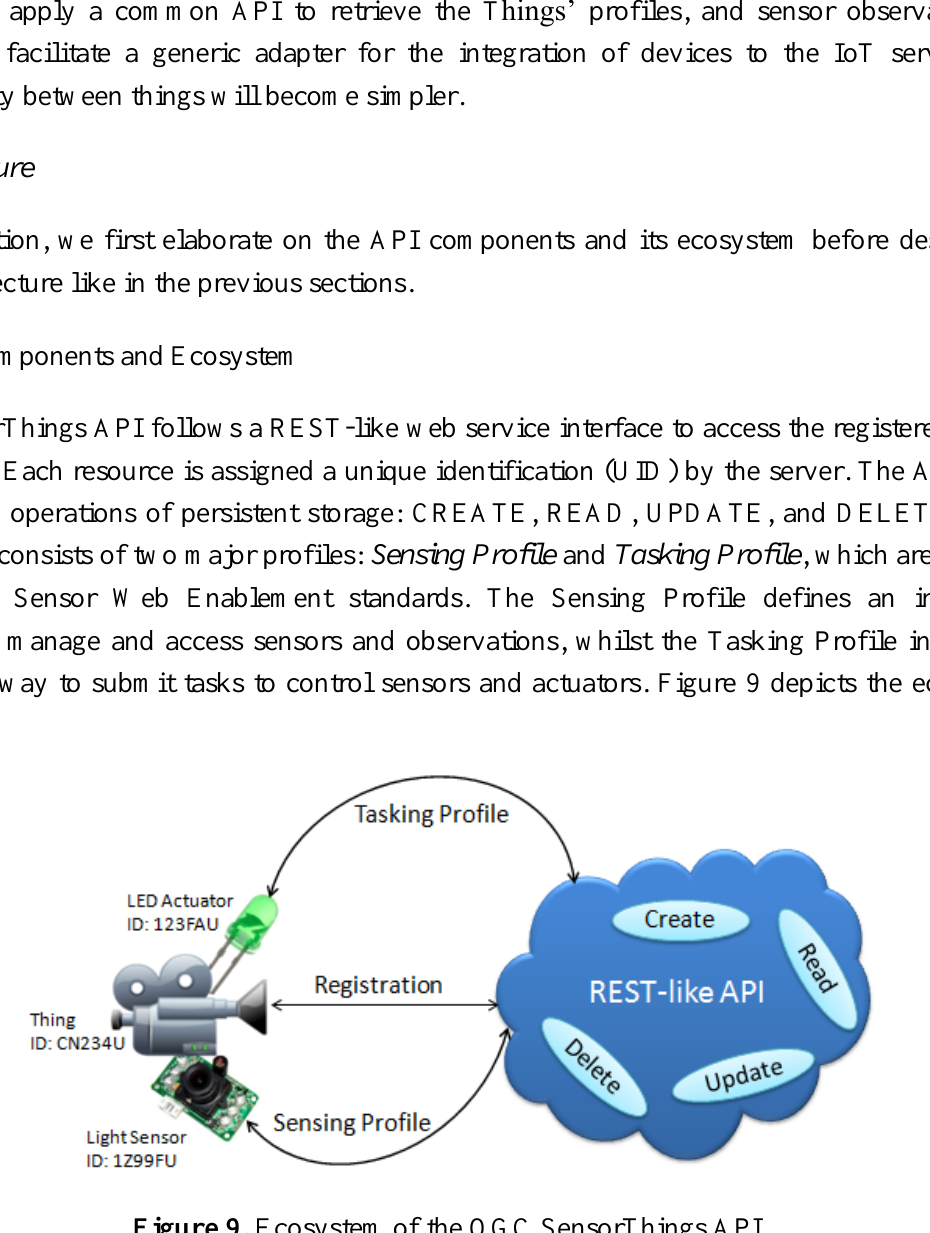
Figure 9. Ecosystem of the OGC SensorThings